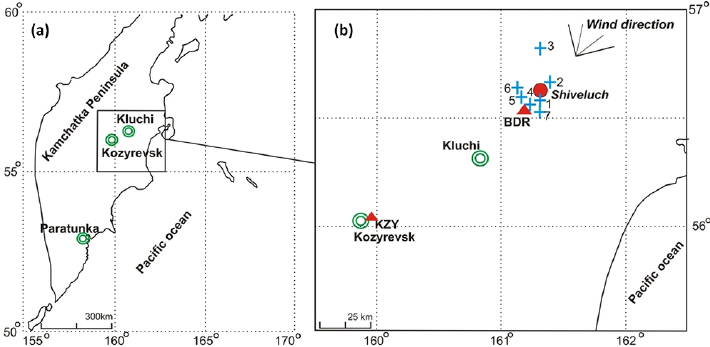
Figure 1. The Shiveluch volcano, observation sites (Kozyrevsk city – KZY), Kluchi and BDR – Seismic station Bajdarnaja) and locations of lightning (1–7).